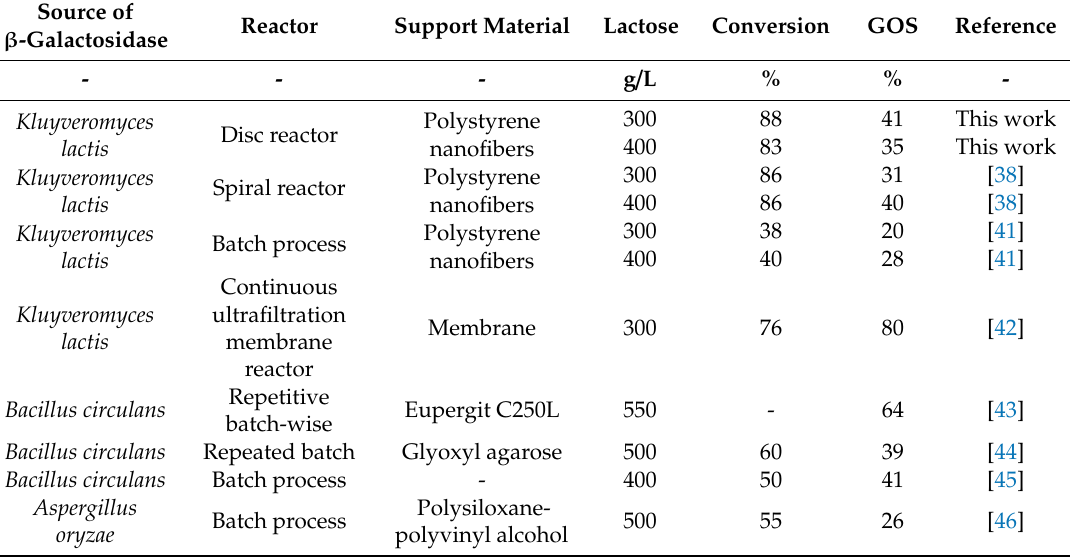
Table 2. Comparison on lactose bioconversion and GOS yield by immobilized enzymes in various types of support